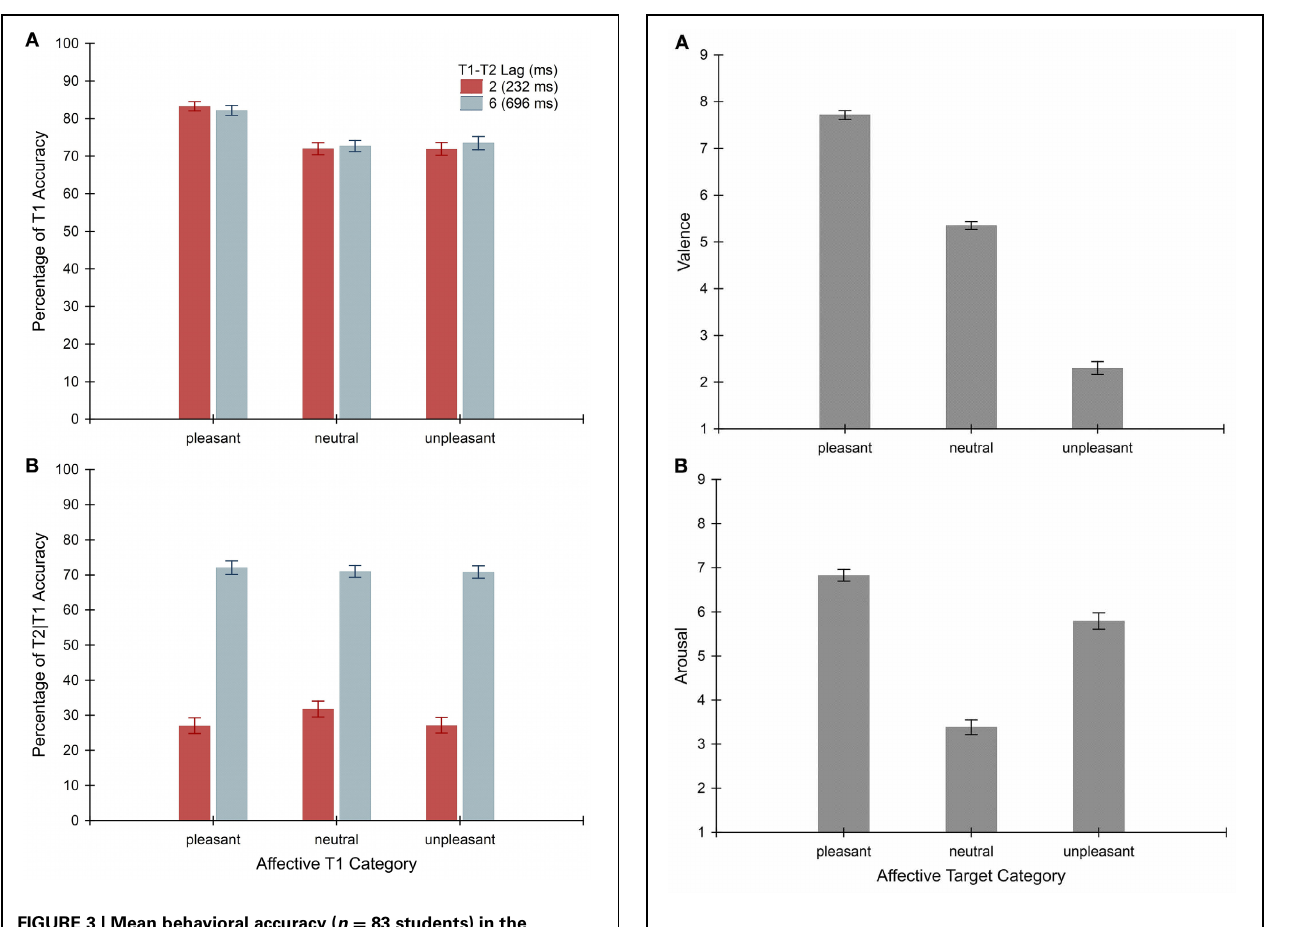
FIGURE 4 | Subjective ratings for 30 randomly selected words from the pleasant, neutral, and unpleasant target lists (10 from each affective category) used in the attentional blink task. Values represent means of 83 students; error bars indicate standard errors of means. Plot (A) depicts valence scores rated on a scale of 1 = highly unpleasant to 9 = highly pleasant. Plot (B) shows ratings on the arousal dimension between the extremes 1 = low and 9 = high